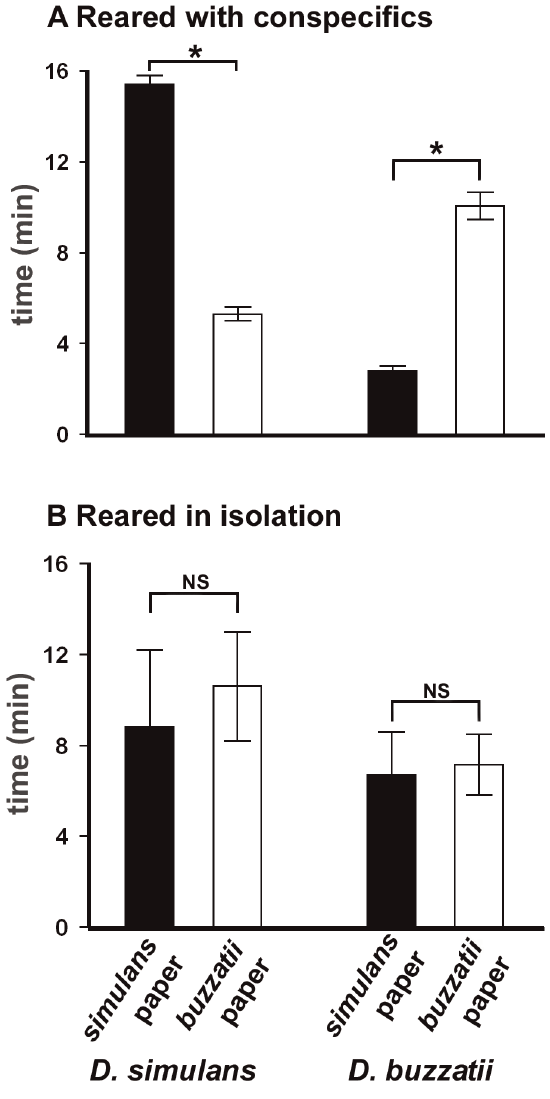
Figure 3. Mean 6 S.E., of pupae of D.simulans and D.buzzatii on conspecific and heterospecific papers . The larvae were of third instar reared with conspecifics (Fig. 3a), and in isolation from conspecifics (Fig. 3b). The larvae were tested individually (N =50 per species). Black columns, percentages of pupae on the simulans paper; white columns percentages of pupae on the buzzatii paper. *Mann- Whitney U -test; P , 0.05; NS = non significant differences (see text for